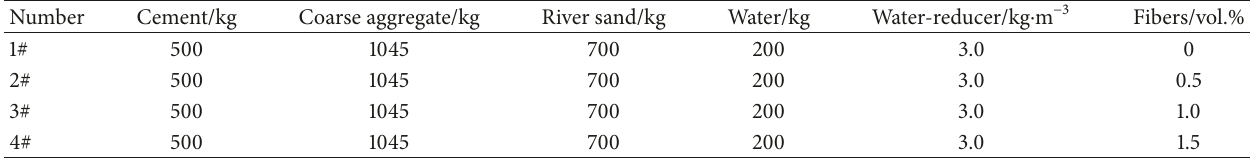
Table 3: Fiber-concrete incorporation ratio design.